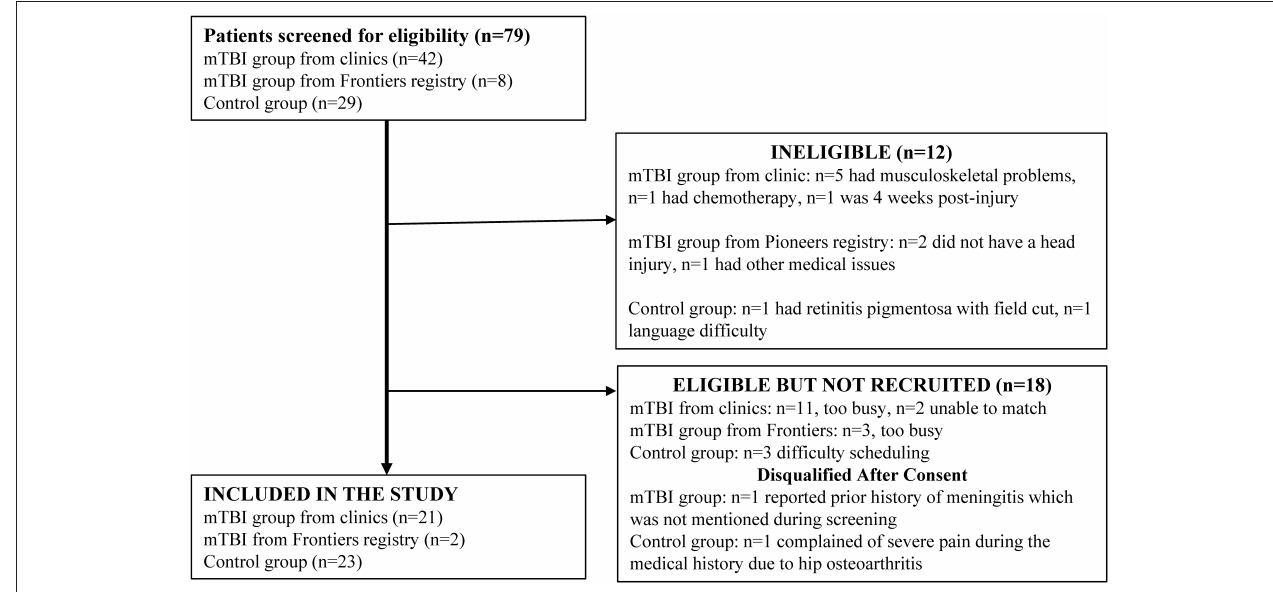
FIGURE 1 | Participant recruitment with reasons for exclusion.